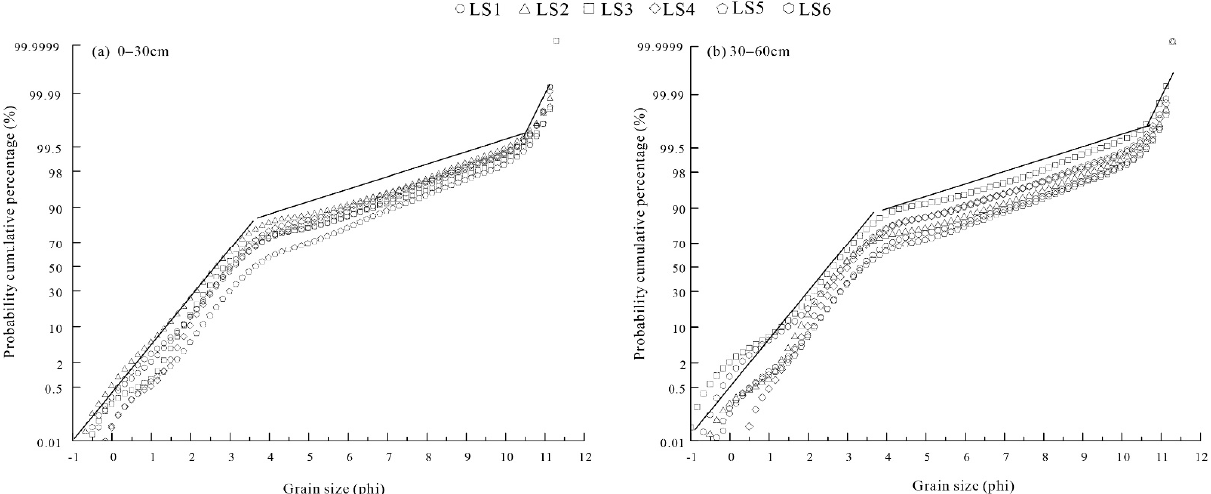
Figure 2. Frequency curves and cumulative curve of grain size composition of sediments collected from different landscapes.